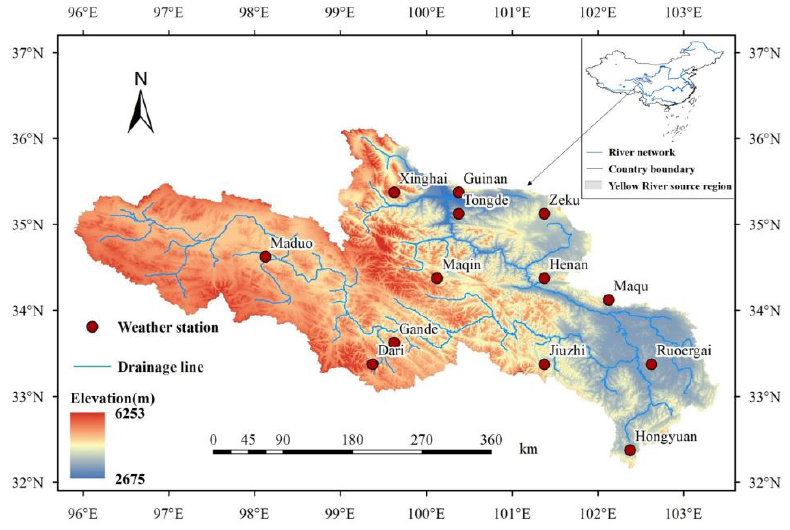
Figure 1. Location of the study area.